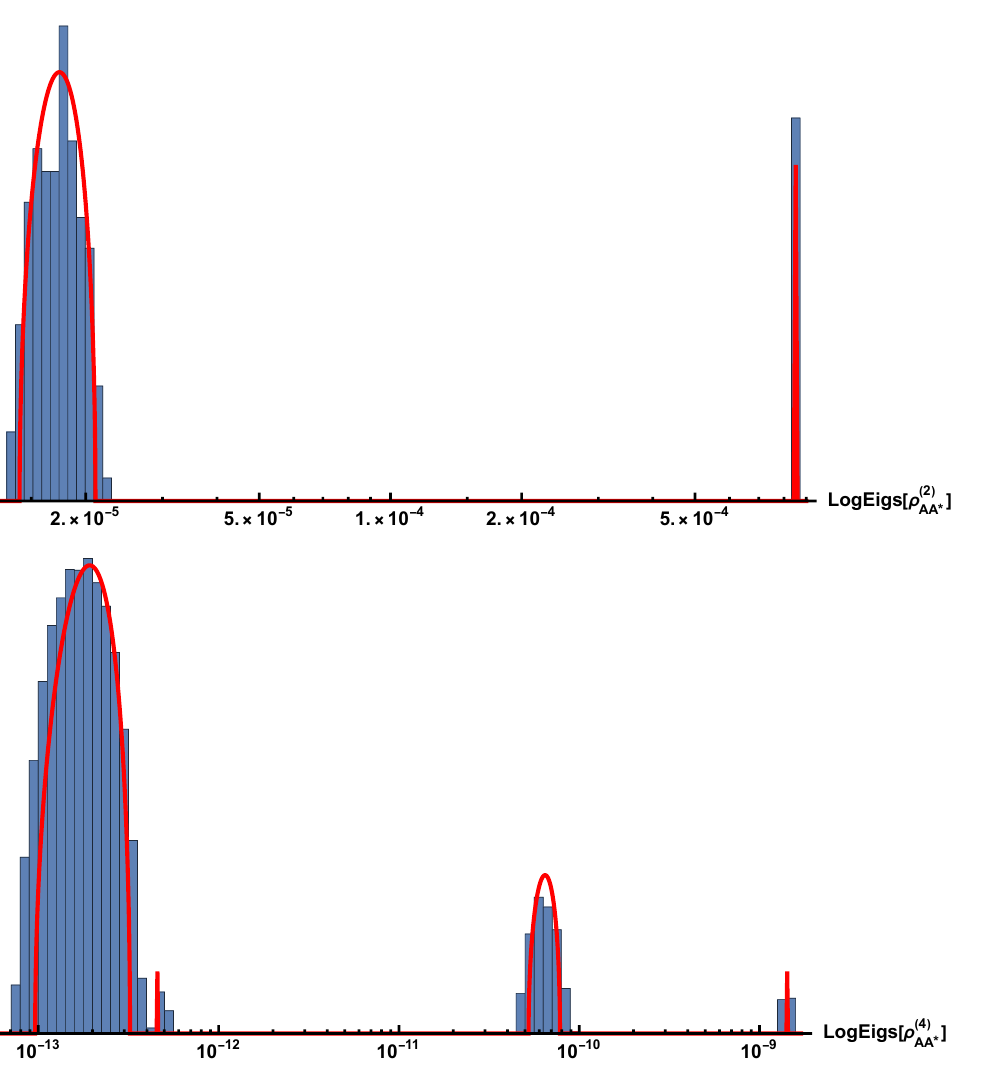
≡ Tr BB ∗ | ρ m/ 2 i h ρ m/ 2 | for AB AB AB